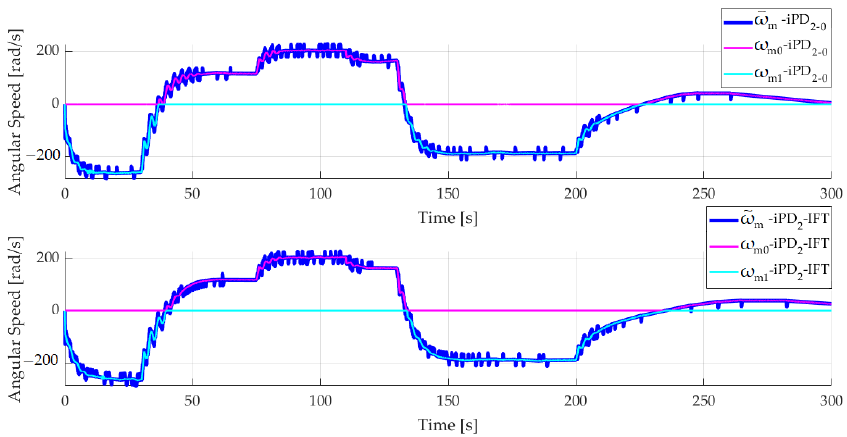
Figure 10. Control signals of the iPD 2 and iPD 2 -IFT controllers and the controlled angular speeds for the pitch angle variations experiment.